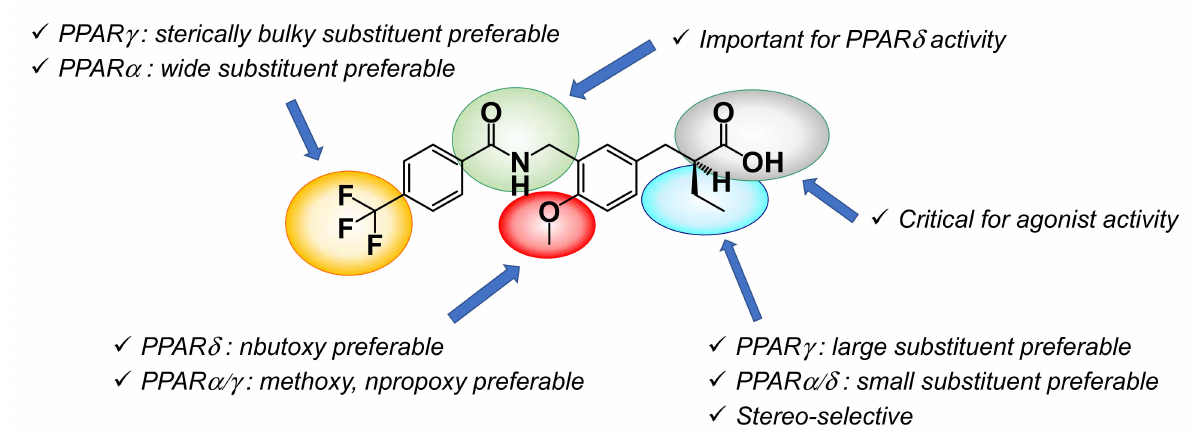
Figure 27. Structure–activity relationship summary of the present series of